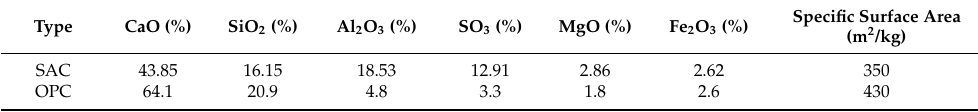
Table 1. Composition and properties of sulphoaluminate